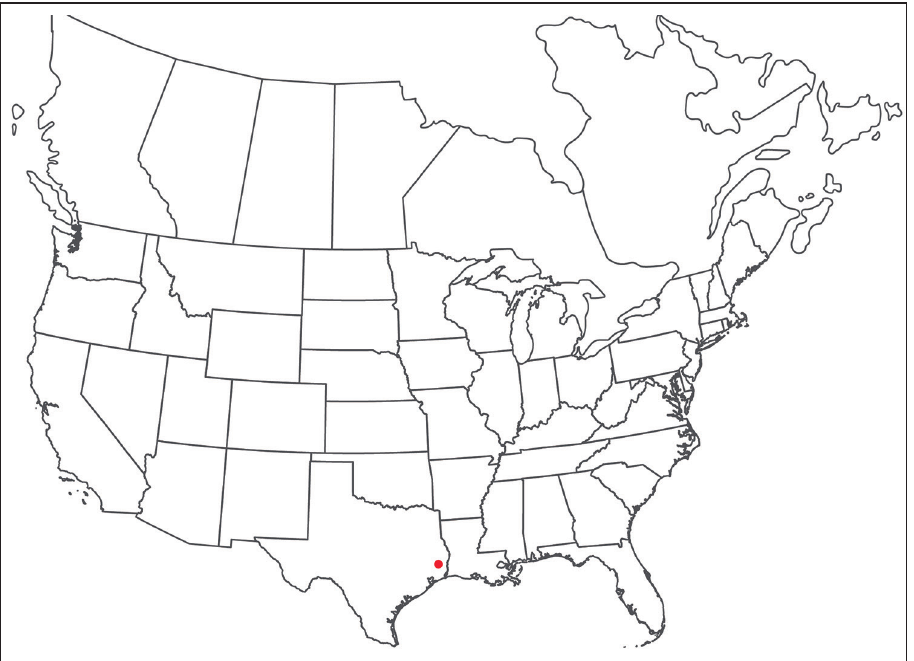
Figure 117. Torrenticola kringi sp. n.